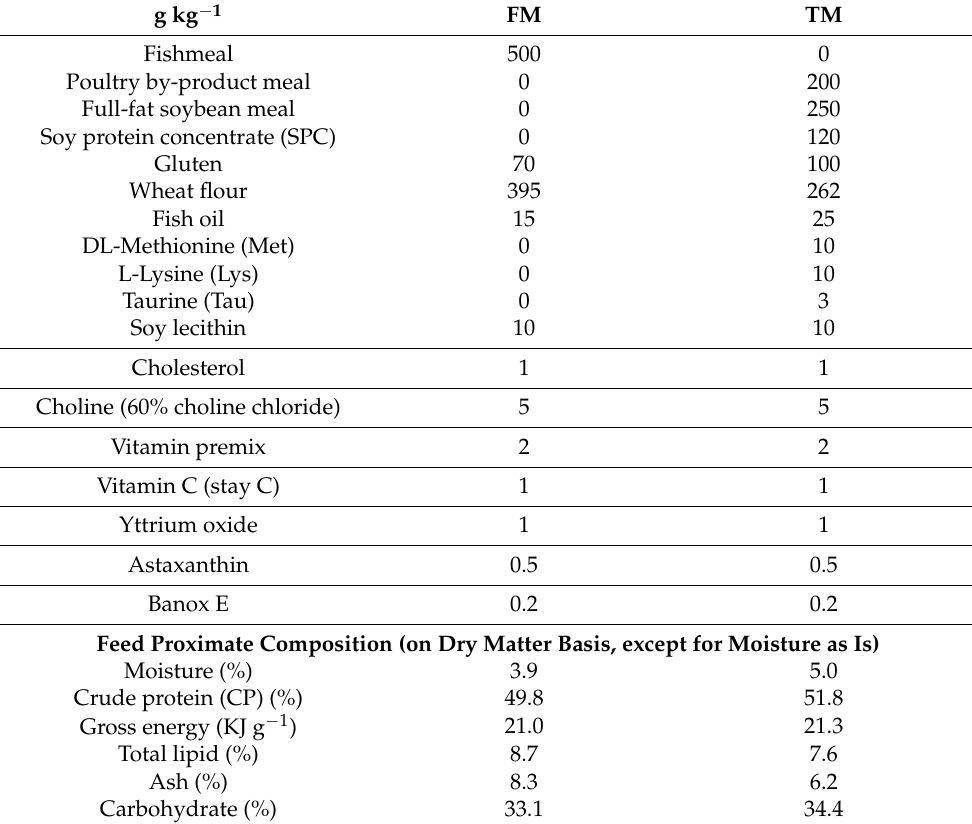
Table 1. Dietary treatment formulation, composition on DM basis and digestible